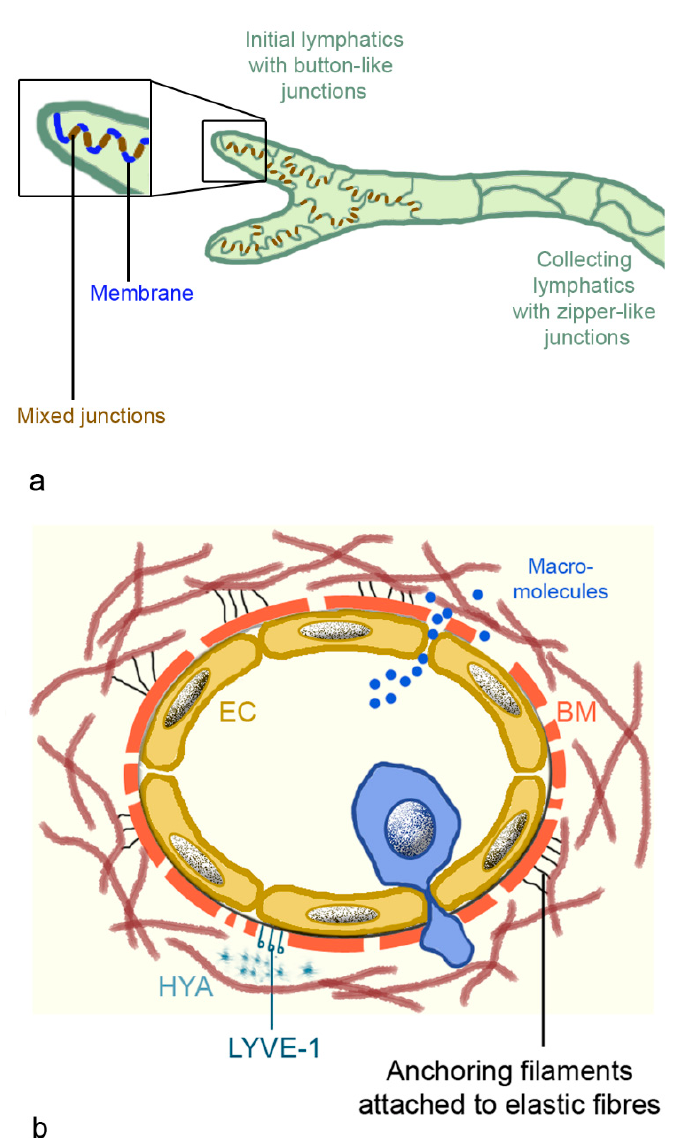
Figure 5. Intercellular junctions of lymphatic capillaries and collecting lymphatics ( a ), and scheme of lymphatic capillaries ( b ). ( a ): Mixed junctions consist of adherent junctions with vascular endothelial (VE) cadherin; β -catenin and p120 catenin; and tight junctions containing claudin 5, occludin, ZO-1, junction adhesion molecule A (JAM-A), and endothelial cell-selective adhesion molecule (ESAM). Membranes between the buttons possess platelet endothelial cell adhesion molecule-1 (PECAM-1) and lymphatic vessel endothelial hyaluron receptor 1 (LYVE-1). ( b ): Lymph capillaries possess an endothelial layer, discontinuous basal membrane, elastic fibers, and anchoring filaments to fix them in the interstitium. Dendritic cells (blue cell) actively migrate into the vessels, while macromolecules can enter the vessel by diffusion. Abbreviation: BM, basal membrane; EC, endothelial cell; HYA, hyaluronan.